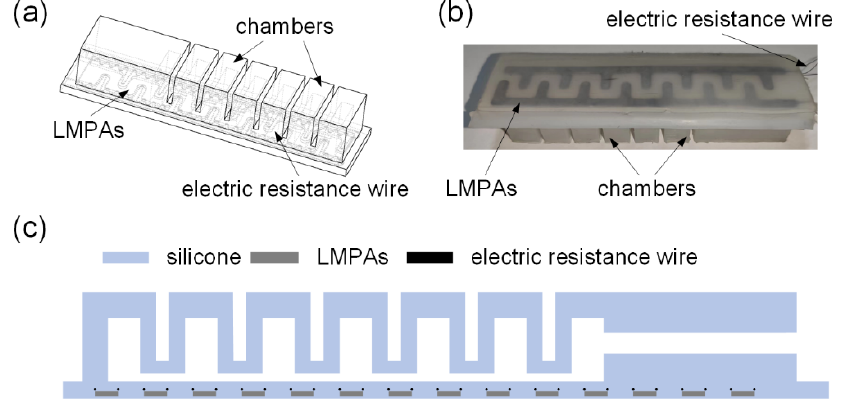
Figure 1. Schematic diagram and the prototype of the VSEAF: ( a ) schematic diagram of the VSEAF in 3D, ( b ) the prototype of VSEAF, and ( c ) schematic diagram of the VSEAF in 2D.